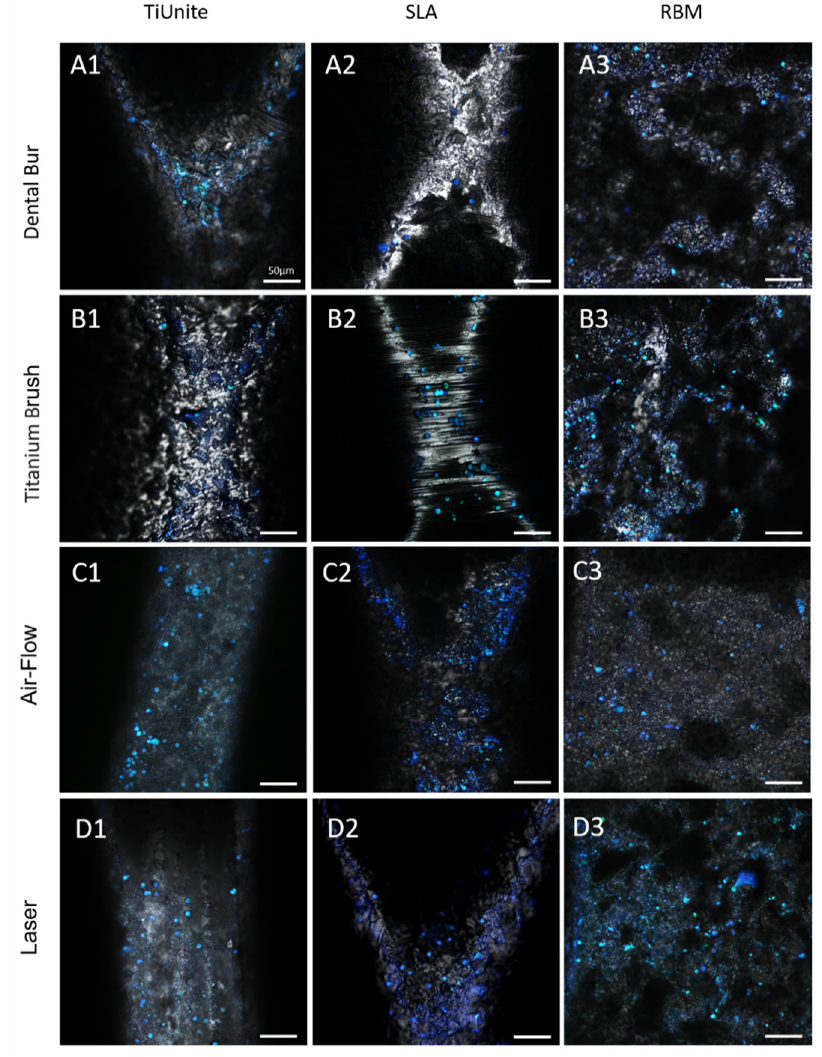
Figure 5. Mesenchymal stem cells growing on the surfaces of the TiUnite ( A1 ), SLA ( A2 ), and RBM ( A3 ) implants isolated from the patients with peri-implantitis and treated with dental bur ( A1 – A3 ), titanium brush ( B1 – B3 ), air-flow ( C1 – C3 ), and laser ( D1 – D3 ).